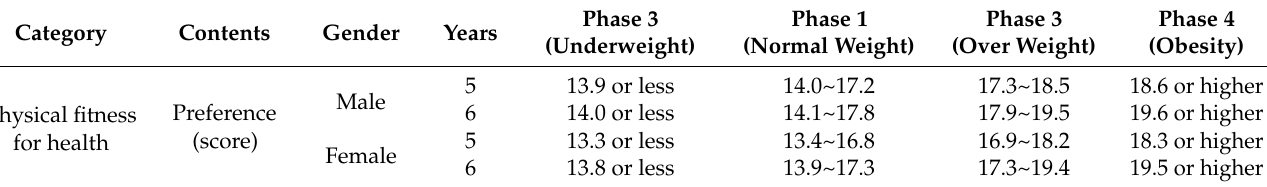
Table A2. Physical activity competence evaluation standards